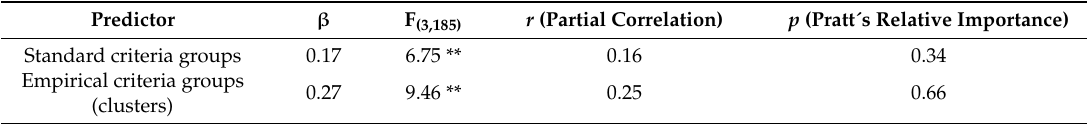
Table 5. Results of the categorical regression analysis (CATREG). Values for predicting conversion to probable dementia of the classification based on standard criteria and classification based on empirical criteria